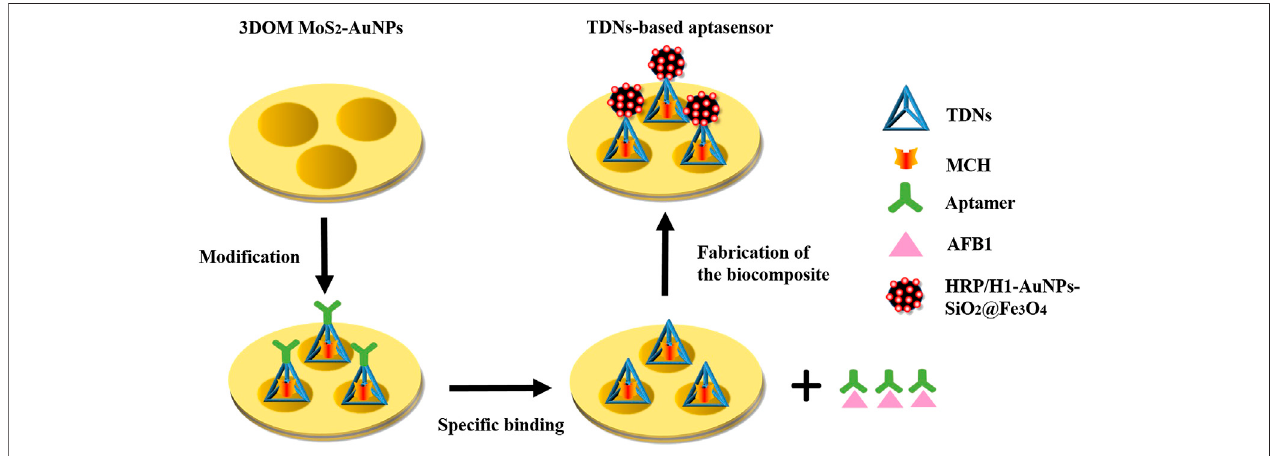
FIGURE 5 | Interface structure diagram of TDNs-based